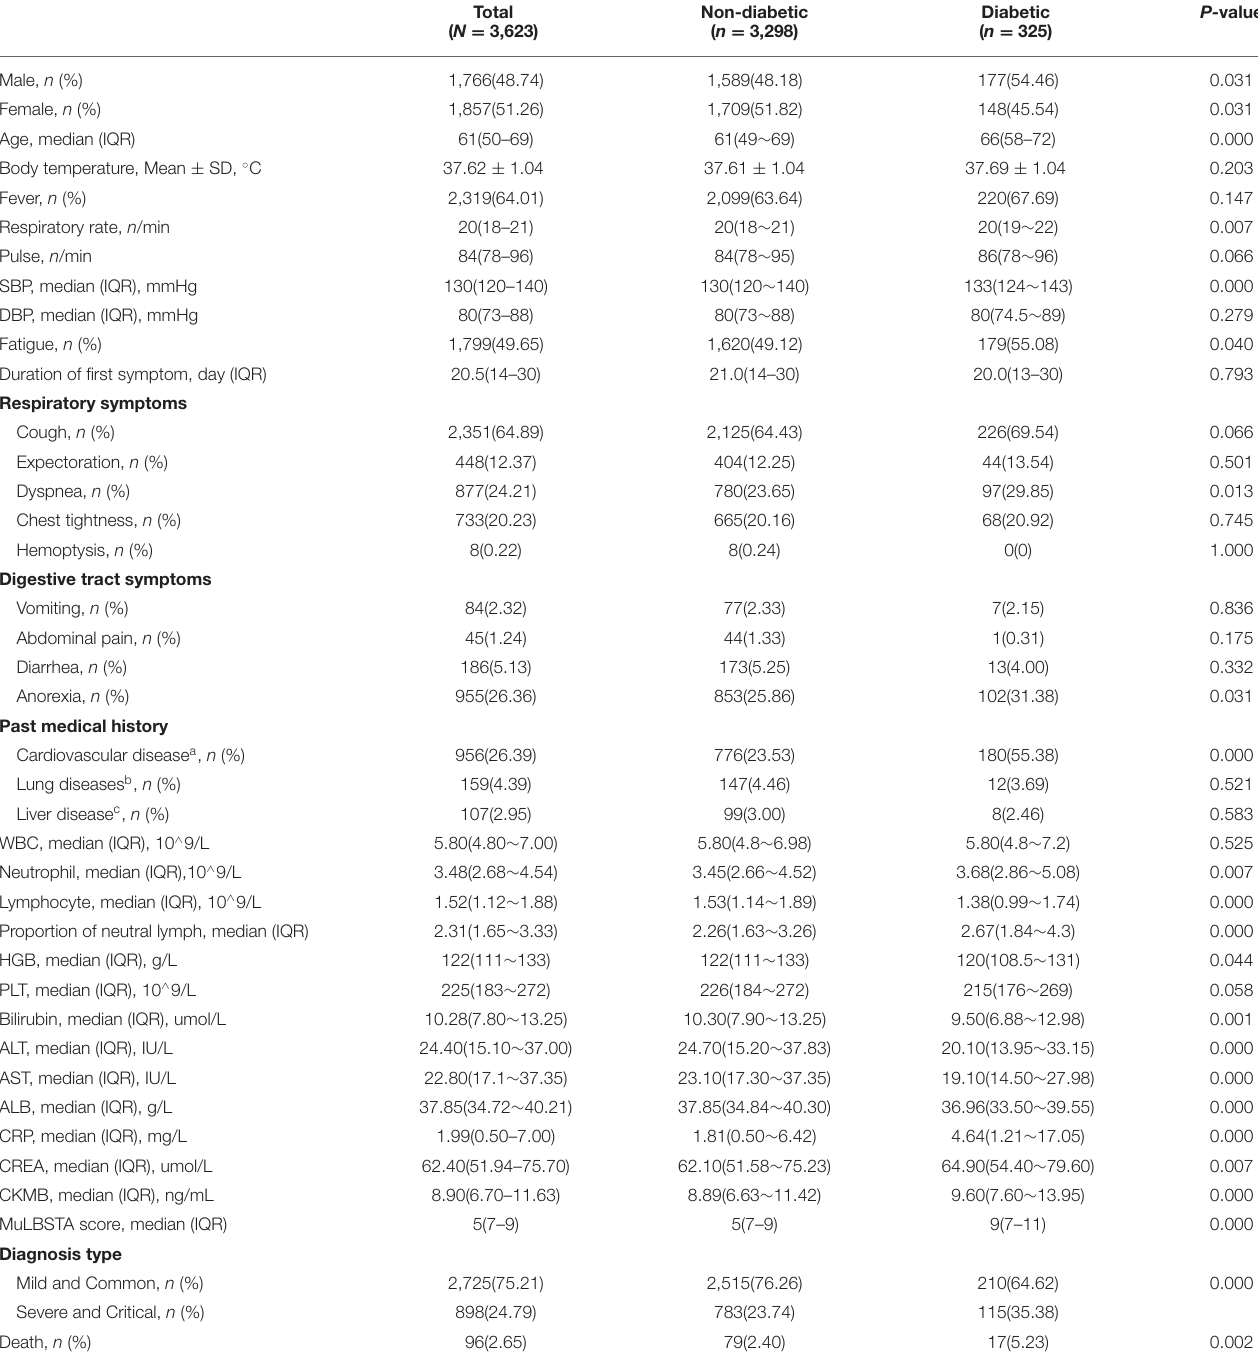
TABLE 1 | Basic characteristics of diabetic and non-diabetic patients with COVID-19 ( N = 3,623). Total Non-diabetic Diabetic P- value ( N = 3,623) ( n = 3,298) ( n =